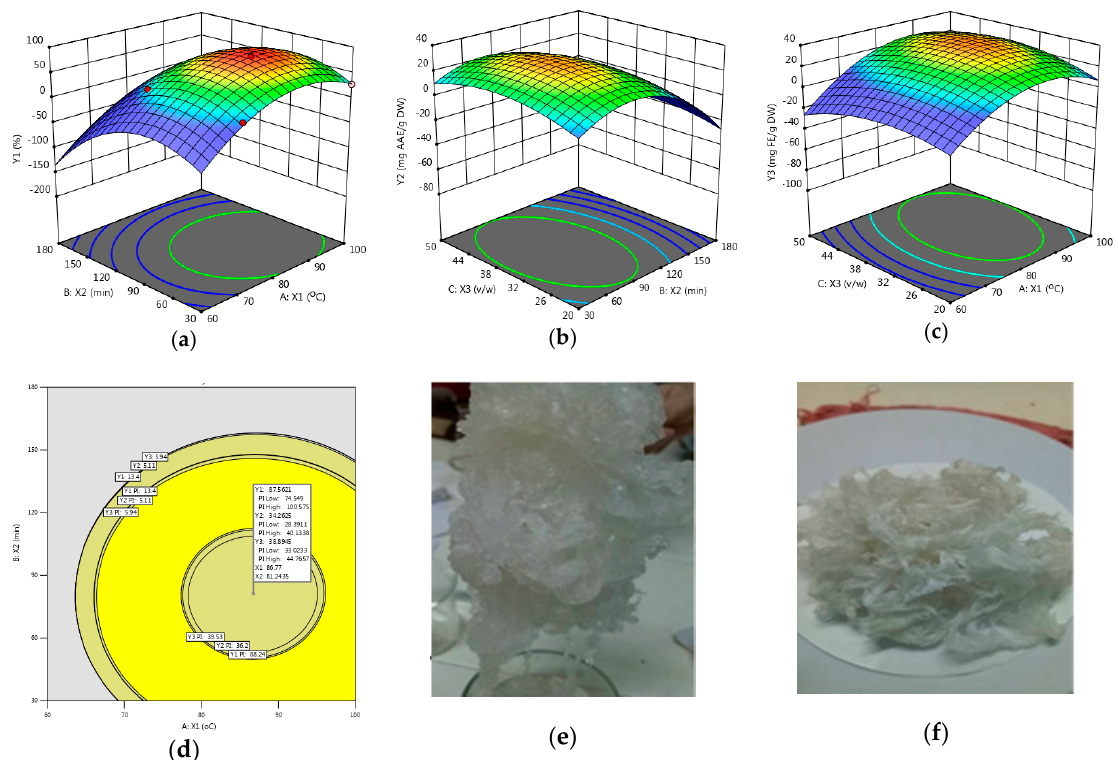
Figure 1. Response surface, overlay surface and antioxidant carrageenan: ( a ) Response surface of Y 1 ; ( b ) Response surface of Y 2 ; ( c ) Response surface of Y 3 ; ( d ) Overlay surface of Y 1, Y 2, and Y 3 ; ( e ) Carrageenan after precipitation using 96% ethanol; ( f ) Carrageenan after drying.